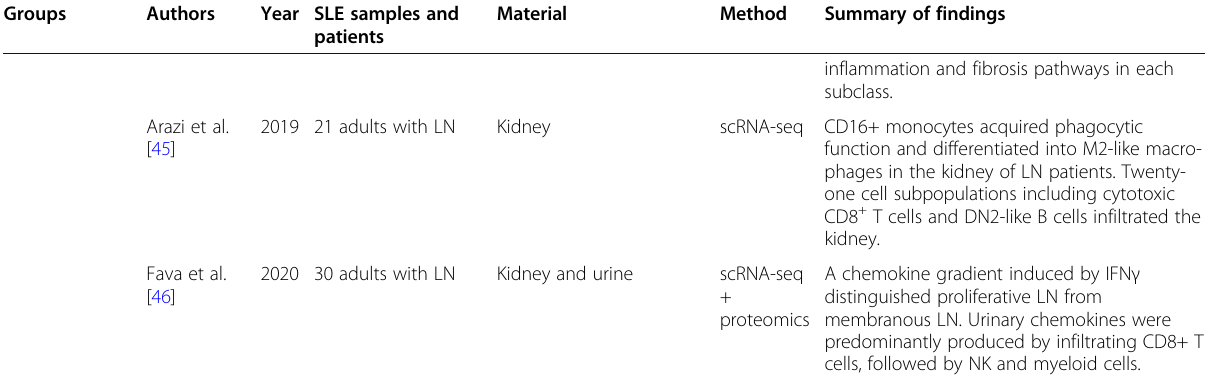
Table 1 Summary of recent transcriptome studies in SLE (Continued)